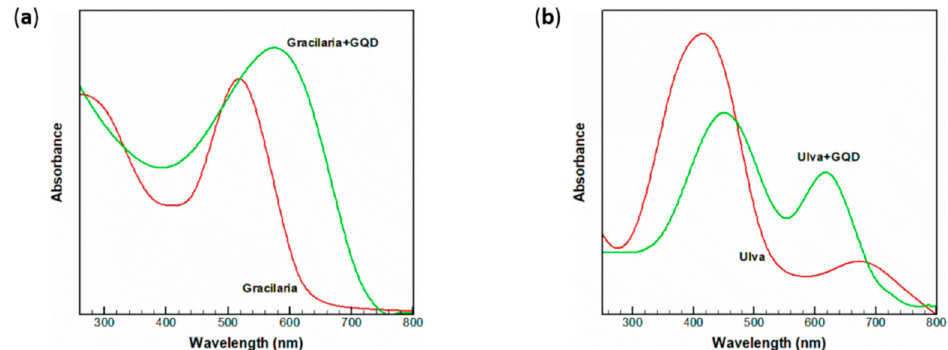
Figure 7. Absorbance spectrum in ethanol of Gracilaria and its hybrid material ( a ), as well as Ulva ( b ). Reproduced from [72] with the permission of